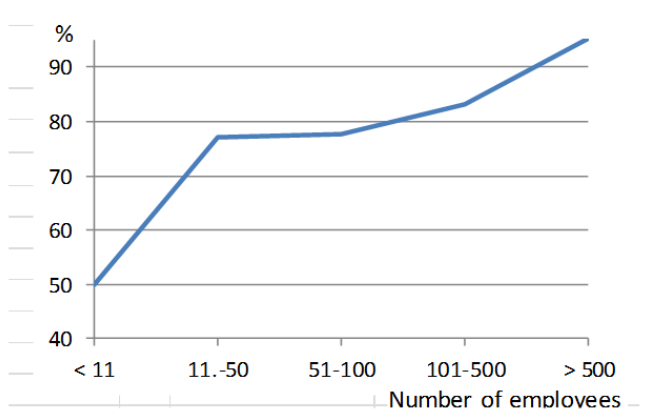
Figure 7. The %EOls average value (on aspects 3 - 26) dependence on the number of employees at v100% i-security